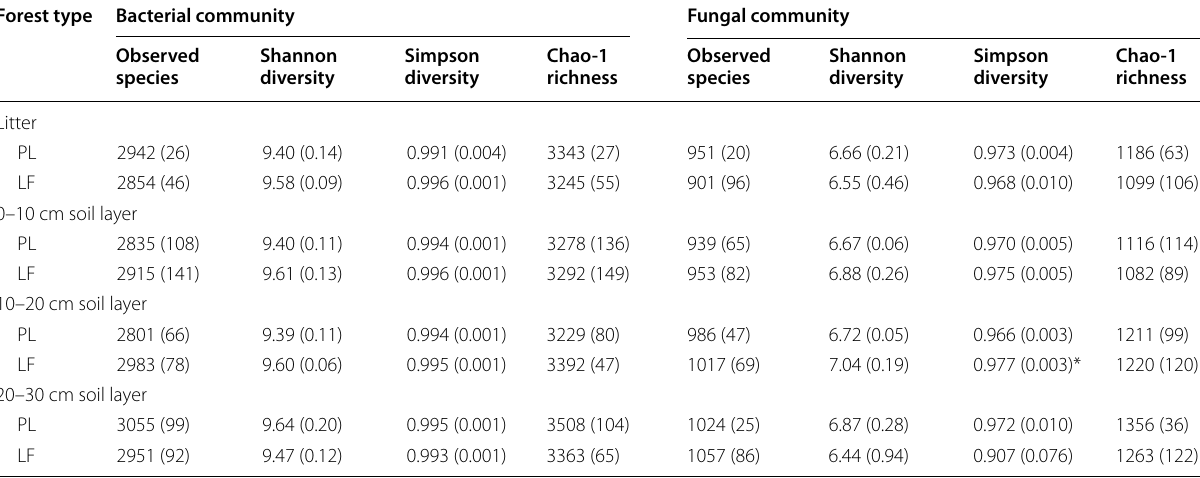
Mean values for n 3 are presented. PL, monoculture L. gmelinii plantation; LF, mixed L. gmelinii – F. mandshurica plantation = * Represents significant differences between the monoculture and mixed plantations at the P < 0.05 level